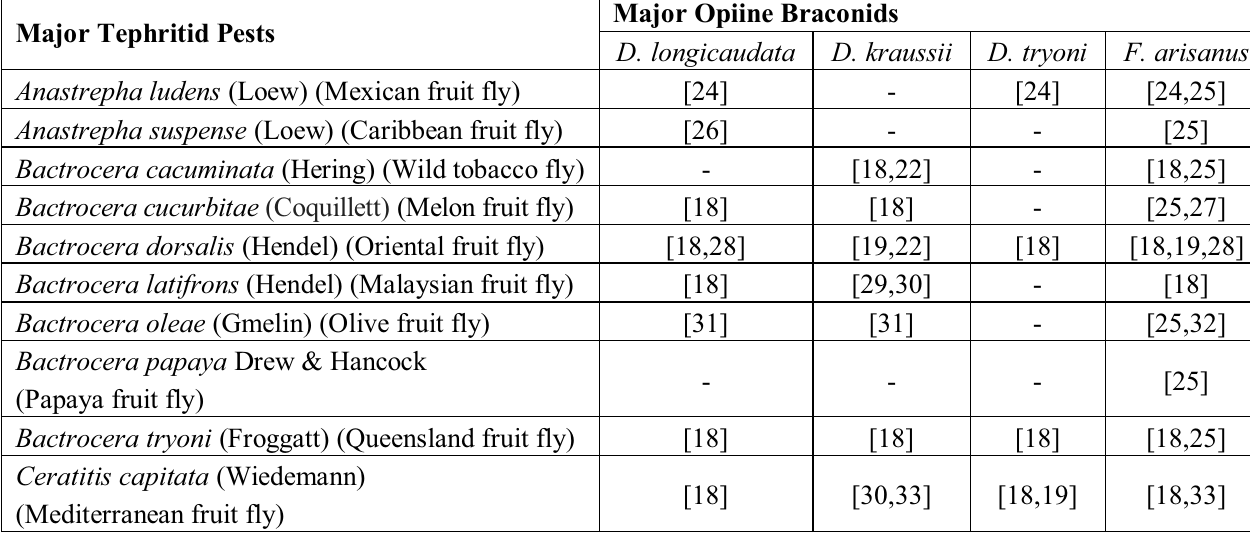
Table 1. Host records of the opiine braconids, Diachasmimorpha spp. and Fopius arisanus parasitising major tephritid pests that occur worldwide. (- indicates no record).